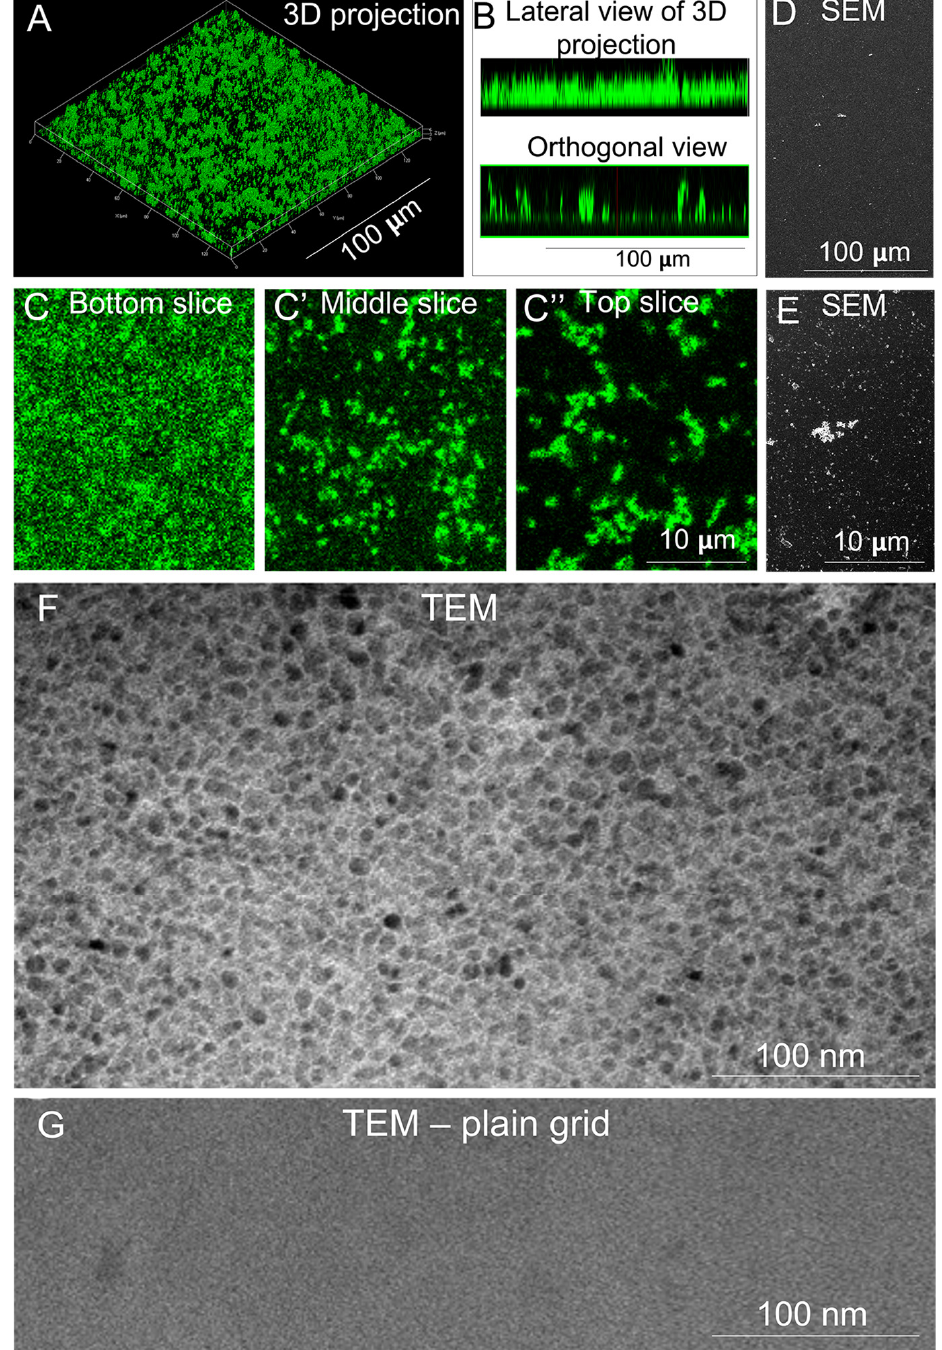
Figure 1. Structural analyses of polylaminin 521 (polyLN521). ( A – C ) The structure of polyLN521 is shown at progressively increasing magnifications from top to bottom rows, using laser scanning confocal fluorescence microscopy, scanning electronic microscopy (SEM,) and transmission electron microscopy (TEM). ( A ) A z-stack of confocal images is depicted after 3D reconstruction using the “surface” option of the ZEN software. B. Side and orthogonal views of the stacks are also shown. Panels ( C – C” ) correspond to 3 optical slices selected to reveal the structure of polyLN521 at the bottom ( C ), middle ( C’ ), and top ( C” ) of the z-stack at higher magnification. ( D , E ) SEM images of polyLM521 at two magnifications. F-G. TEM images after the negative staining of polyLN521 ( F ) and of the plain copper grid that supports the sample ( G ). The polygonal-like pattern observed in ( F ) corresponds to the supramolecular array of the protein and not to the mesh of the grid support.